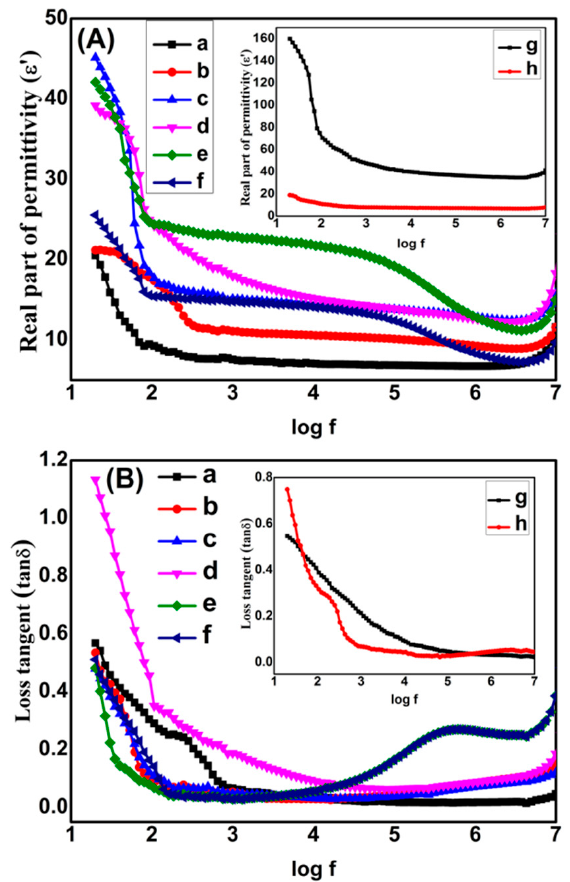
Figure 4. ( A ) Dielectric constant ( ε′ ) ( B ) loss tangent (tan δ ) of ( a ) PVDF ( b ) G1T10PVDF ( c ) G2T10PVDF ( d ) G3T10PVDF ( e ) G4T10PVDF ( f ) G5T10PVDF ( g ) G4T20PVDF ( h ) G4T30PVDF.